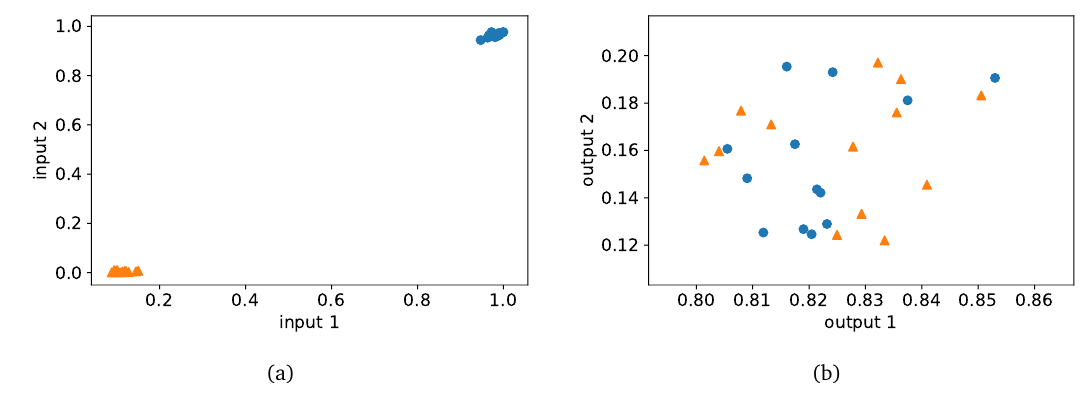
Figure 7: An example of a non-injective region in the “comparison sample” map generated by an ANN trained with a loss function that favors foldings, see Eq. (13). Points in two distinct regions in the input space (a) map onto the same region in the output space